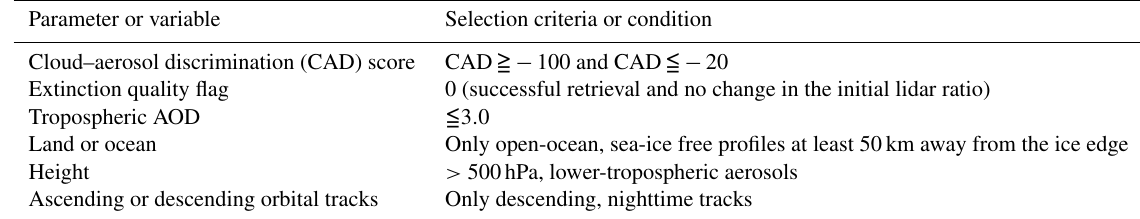
Table 1. The selection criteria adopted in this study for the processing of CALIOP